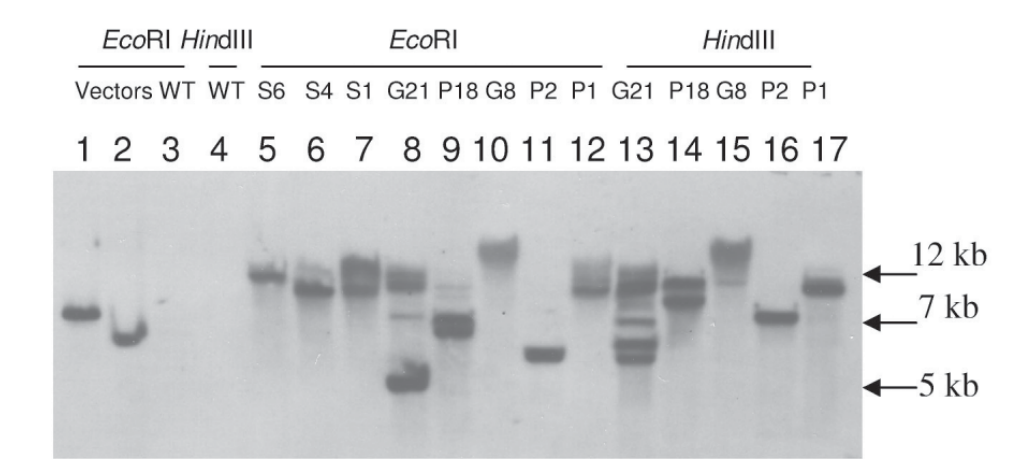
Fig. 2. Southern blot hybridised with a DIG-labelled hygromycin B phosphotransferase ( hph ) gene fragment. Lane 1, pBCH linearised with Eco RI; lane 2, pAN7-1 linearised with Eco RI; lanes 3 and 4, genomic DNA from wild-type Eutypa lata E10-10 digested with Eco RI and Hin dII respectively; lanes 5–17, genomic DNA from transformants digested with Eco RI (lanes 5–12) or Hin dIII (lanes 13–17). Transformants obtained using pCT74 (S1, S4, S6), pBCH- gfp (G8, G21) or pAN7-1 (P1, P2,